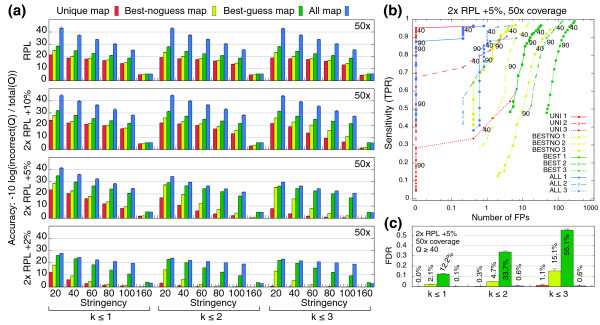
Genotyping performance on simulated data sets. (a) Bar charts report Sniper genotyping accuracy based on resequencing of four different synthetic genomic DNA templates. Sample genomes were generated from each known template by introducing single nucleotide sequence variation randomly to 0.1%. We simulated 36-nucleotide PE reads from each unknown genome to 50-fold coverage and mapped them to the respective known genomic template according to a unique (red), best no-guess (yellow), best guess (green), or total (blue) mapping strategy using k = 1, 2, or 3 mismatches, as shown. Accuracy for each bar was determined using only those genotype loci identified at or above the specified stringency level Q = -10 log10(1 - P), where P is the posterior probability of the MAP genotype at a single nucleotide locus. Error bars represent ± standard deviation across five replicate simulations of generating a new sample genome and simulating reads from this genome. (b) Receiver operating characteristic (ROC) styled plot relating genotyping sensitivity, TPR = (TP + TPFG)/(TP + TPFG + FN) (where TP = true positive loci, FN = false negative loci, and TPFG = true position, false genotype loci, to number of false positives (FPs) for simulation results genotyping the moderate difficulty Yeast 2 × RPL + 5% template at 50-fold coverage; as in (a), each point represents the average over five replicates. Points representing stringency levels Q ≥ 40 and Q ≥ 90 are labeled for clarity. (c) Bar chart reporting the estimated false discovery rate FDR = (FP + TPFG)/(TP + FP + TPFG) for genotyping the Yeast 2 × RPL + 5% template at 50-fold coverage using Q ≥ 40 confidence. Error bars represent ± standard deviation over five replicates, as in (a). See Additional file 14 for a complete description of estimates.